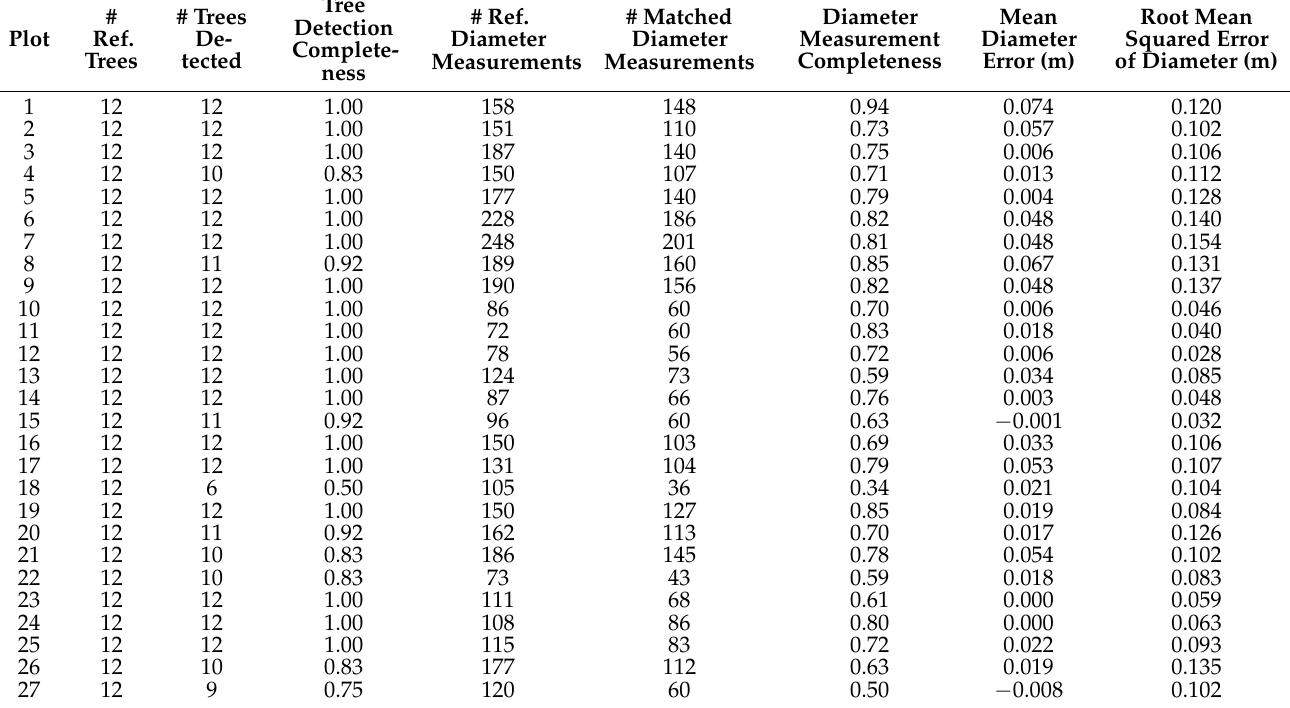
Table A1. Western